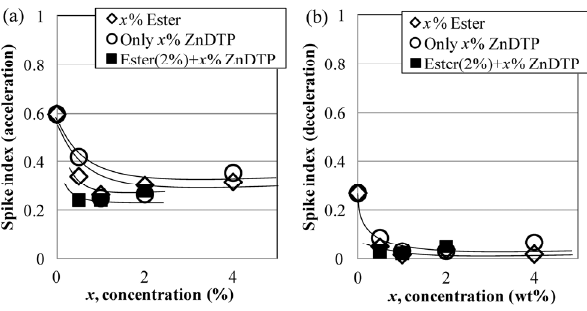
Fig. 8 Correlation between additive concentration and averaged friction coefficient at (a) 3.14 mm/s and (b) 62.8 mm/s.